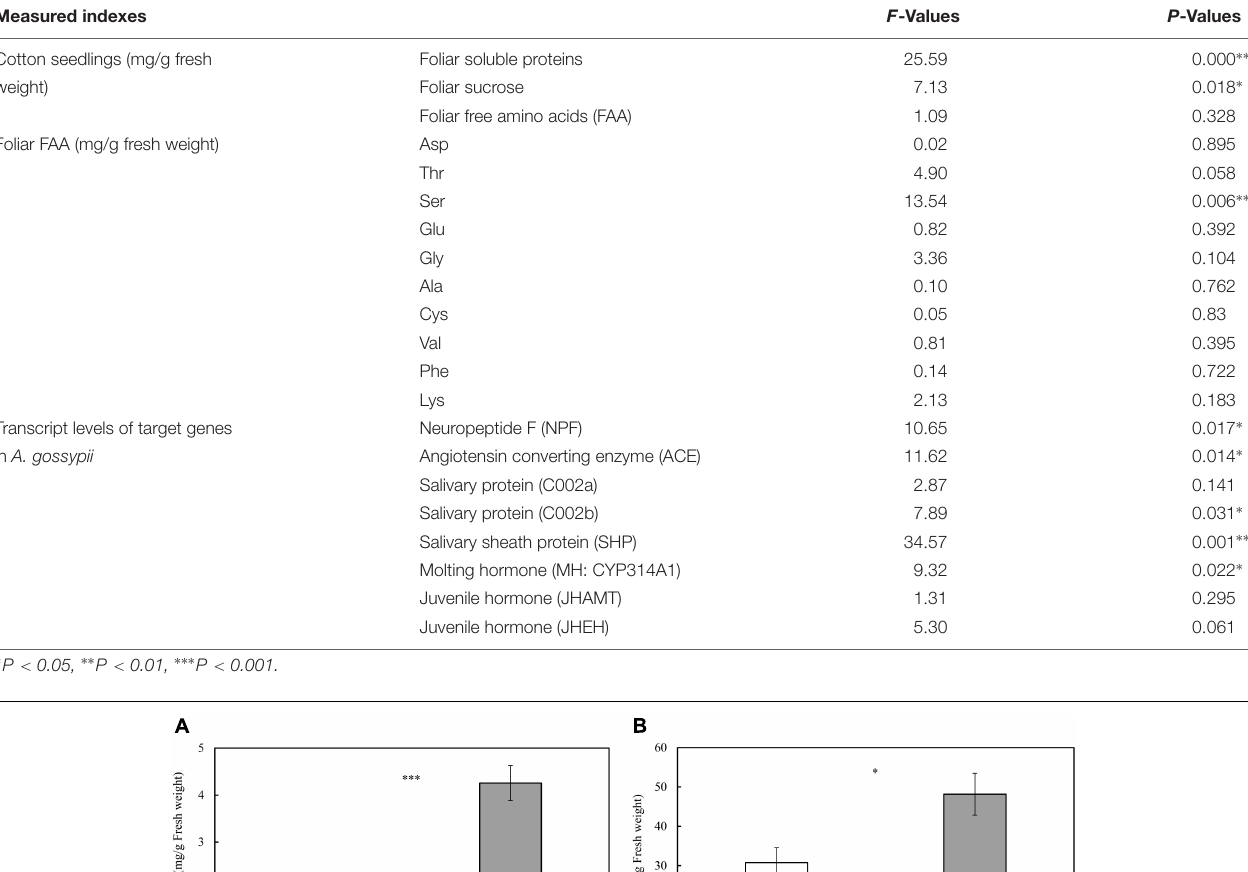
TABLE 3 | One-way analyses of variances (ANOVAs) for the effects of CO 2 levels (i.e., ambient vs. elevated) on the foliar contents of soluble constituents of cotton seedlings, and the transcript levels of the target genes related to growth, development, and fecundity of the cotton aphid A. gossypii fed on the fully expanded leaves excised from the 35- to 60-day-old cotton seedlings grown under ambient and elevated CO 2 conditions. Measured indexes F -Values